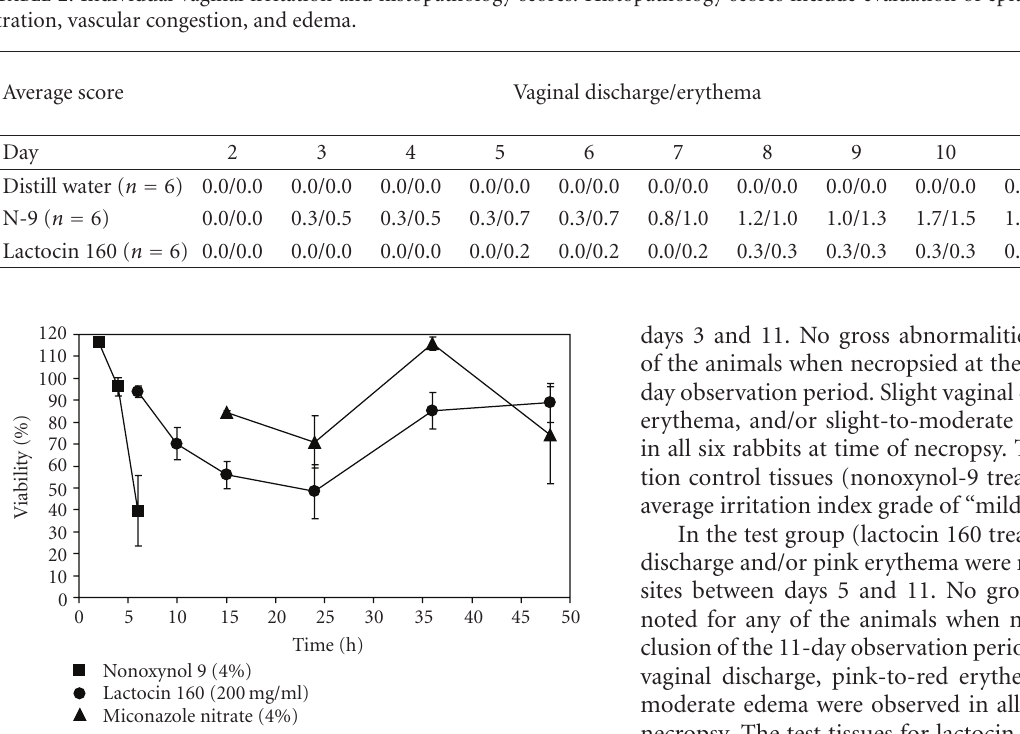
Figure 1: Lactocin 160 preparation is not toxic for human vaginal cells as tested in EpiVaginal tissue (VEC-100) model. The presented data illustrate %viability versus time (hours) for following prepara- tions: (cid:2) , nonoxynol 9 (4%); • , lactocin 160 (200mg/mL); (cid:3) , mi- conazole nitrate